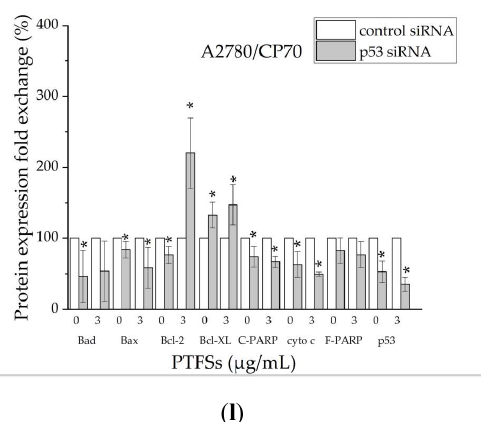
Figure 6. The changes in protein expressions in ovarian cancer cells apoptosis treated with PTFSs via p53 pathway. The quantification histograms are shown with error bars. Data represent means ± SD from three independent experiments. ( a, b, c ) The effects of PTFSs on the protein expression of phospho-p53 (Ser15) and p53 determined by Western blotting in A2780/CP70 and OVCAR-3 cells. ( d, e ) Cellular apoptosis was measured after cells were treated with PTFSs and p53 inhibitor PFT-α for 24 h and then stained with Hoechst 33342 in A2780/CP70 ( d ) and OVCAR-3 ( e ) cells (×400). ( f ) Bar charts represent the ratio of JC-1 aggregates to JC-1 monomers (ratio of 590:530 nm emission intensity) of A2780/CP70 cells, which reveals ΔΨm dissipation after 24 h treatment with or without PTFSs or p53 inhibitor PFT-α. ( g, h ) caspase 3/7 and caspase 9 activities were determined after treatment with PTFSs and p53 inhibitor PFT-α for 24 h in A2780/CP70 cells. ( i, j ) The effects of pre-incubation of PFT-α (20 μM) on the protein expression of Apaf-1, Bax, Bcl-XL, cleaved caspase-3 and -9, full length PARP and cleaved PARP determined by Western blotting in A2780/CP70 cells. ( k, l ) The effects of p53 siRNA (50 nM) on the protein expression of Bad, Bax, Bcl-2, Bcl-XL, full length PARP and cleaved PARP and cytochrome c determined by Western blotting in A2780/CP70 cells. GAPDH protein expression was detected by Western blotting and utilized for an endogenous reference to standardize protein levels. * p < 0.05, compared with respective controls. CC3, CC9, C-PARP, F-PARP, and cyto c are the abbreviations of cleaved caspase 3, cleaved caspase 9, cleaved PARP, full length PRAP, and cytochrome c, respectively.